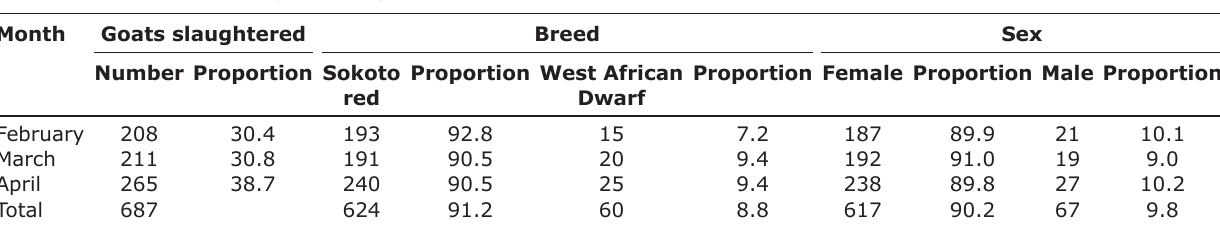
Table-1: Breed and sex of goats slaughtered. Month Goats slaughtered Breed Sex Number Proportion Sokoto red